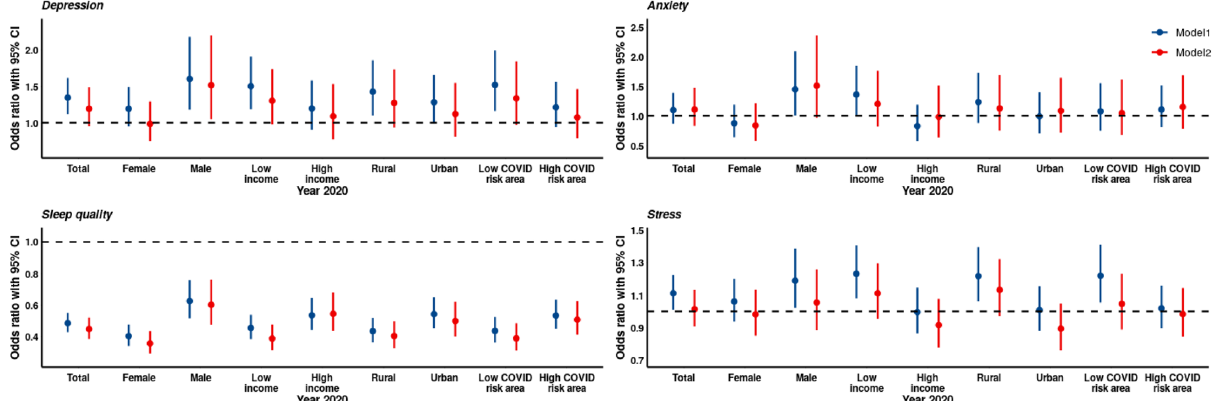
Figure 5. The association between survey year (2020 versus 2019) and moderate to severe depression, moderate to severe anxiety, stress, and good sleeping quality. Notes: Model 1 adjusted for age and sex. Model 2 adjusted for age, sex, exercise habit, time spent outdoors, and time spent on mobile